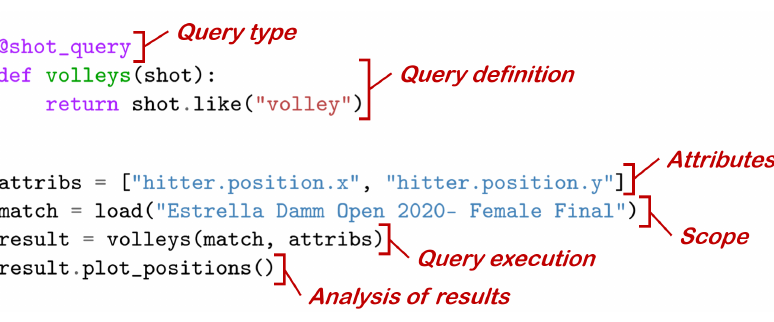
Figure 6. Simple query using the proposed API, along with its main